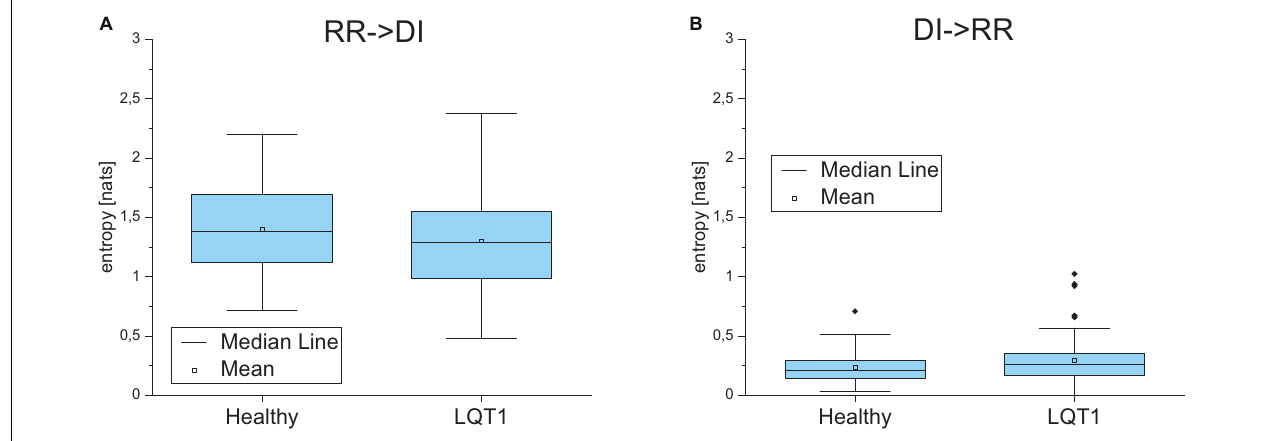
FIGURE 13 | (A) Transfer entropy from the RR intervals to the diastolic intervals and in the opposite direction (B) for healthy individuals and for LQTS1 patients. p -Values: RR- > DI: 0.3764, DI- > RR: 0.20194.